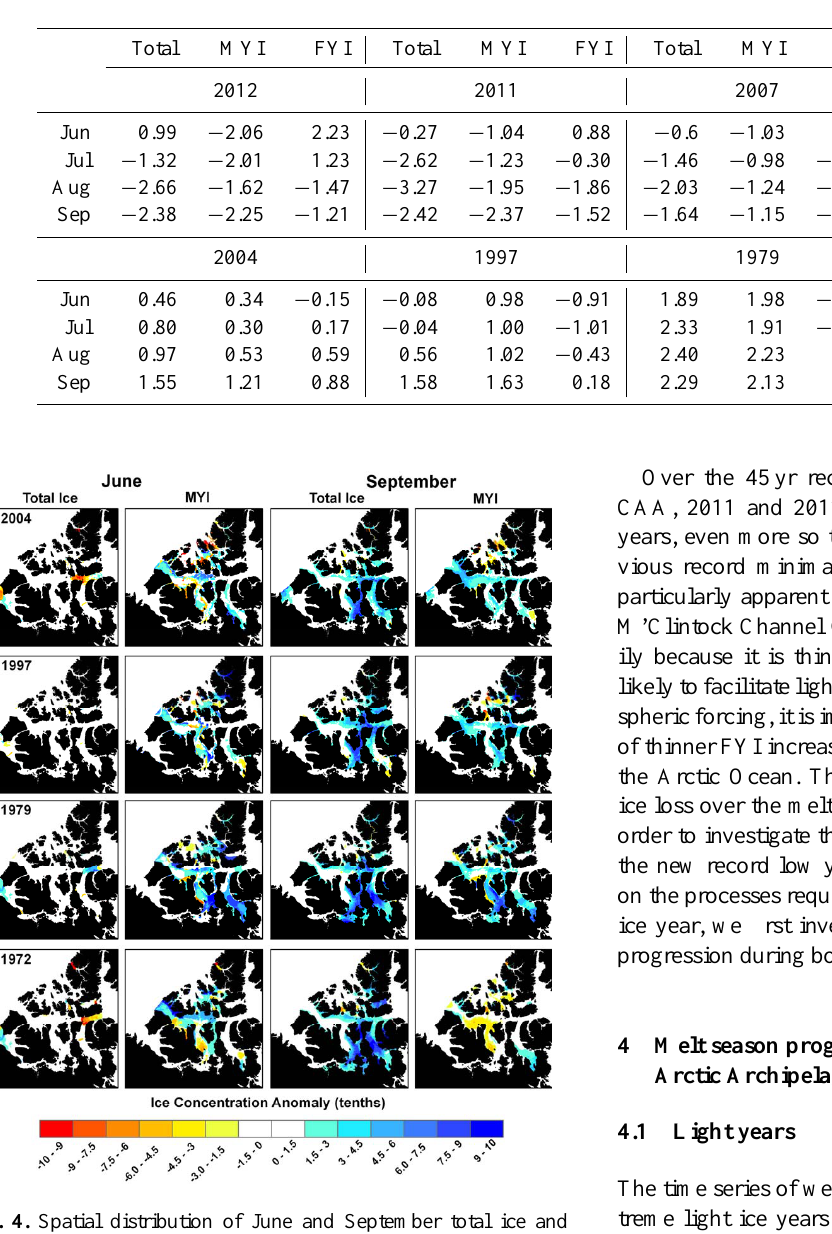
Table 2. Monthly June to September total, multi-year ice (MYI) and first-year ice (FYI) standardized anomalies for extreme light and heavy sea ice years in the Canadian Arctic Archipelago. The top rows are light ice years and the bottom rows are heavy ice years. Standardized anomalies calculated with respect to the 1981–2010 climatology.